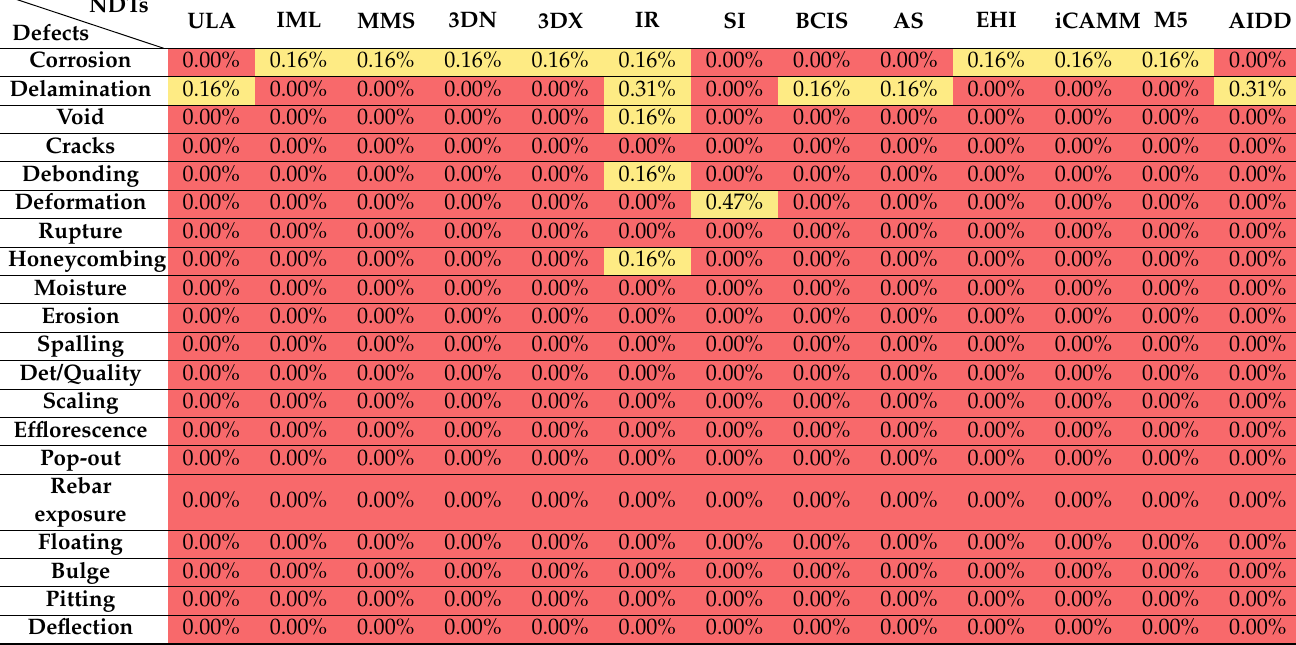
Table 12. Literature review matrix of concrete bridge defects and other used NDTs